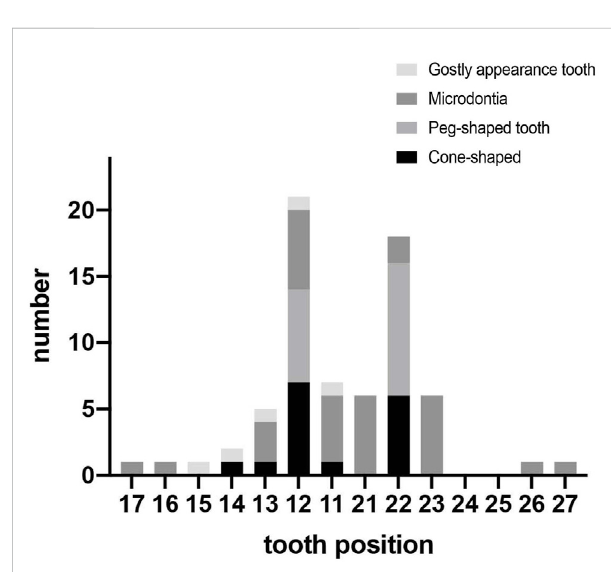
FIGURE 7 Number of teeth with abnormal morphology in permanent dentition in patients with non-syndromic oligodontia ( n = 151) caused by PAX9 gene